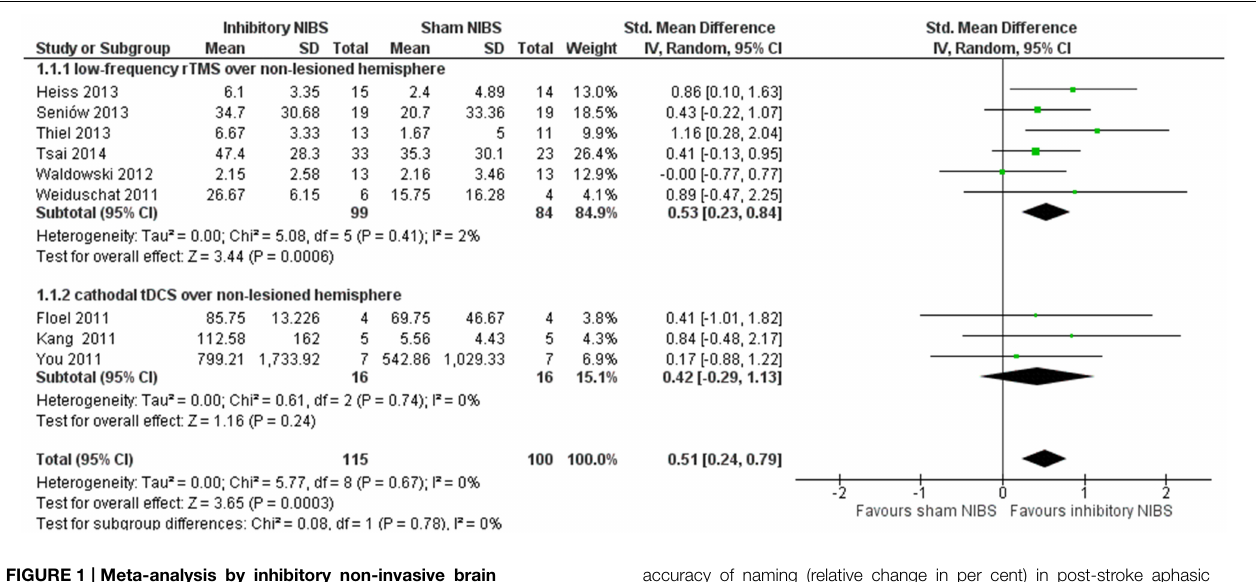
accuracy of naming (relative change in per cent) in post-stroke aphasic patients until end of intervention phase, inhibitory NIBS vs. sham NIBS. All included trials utilized inhibitory NIBS and sham NIBS in combination with